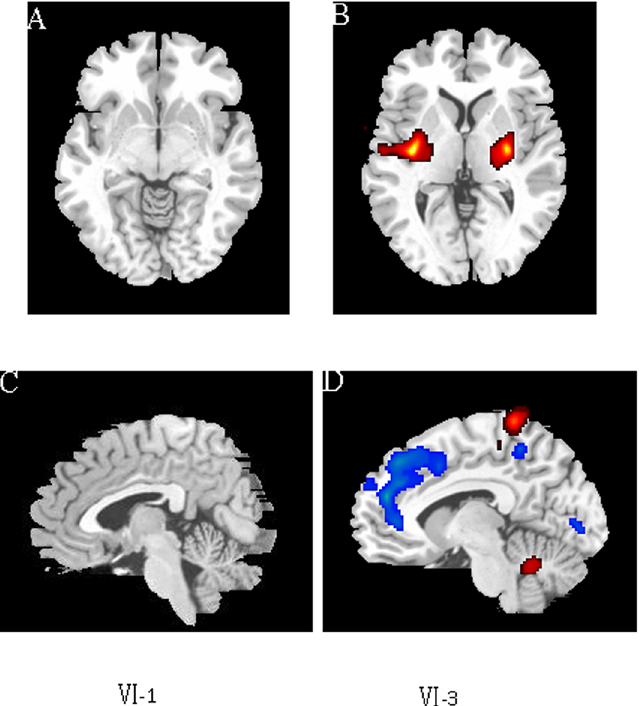
Fig 4. PDRP via 18 F-FDG in pedigree with p.N279K MAPT mutation. Parkinson ’ s disease-related pattern (PDRP) identified by network analysis of 18 F-FDG PET scans from two family members – patient Ⅳ -3 matched with non-patient Ⅳ -1. A, B: Axial PDRP of [ 18 F]-FDG PET scans from two family members, A, Ⅳ -1, B, Ⅳ -3; C, D: Sagittal PDRP of [ 18 F]-FDG PET scans from two family members, C, Ⅳ -1, D, Ⅳ -3. Red signals in putamen (B), globus pallidum (B), cerebellum (D) and sensorimotor cortex (D) indicate the brain regions with increased metabolic activity, whereas blue signals in extensive prefrontal areas (D) indicate the brain regions with decreased metabolic